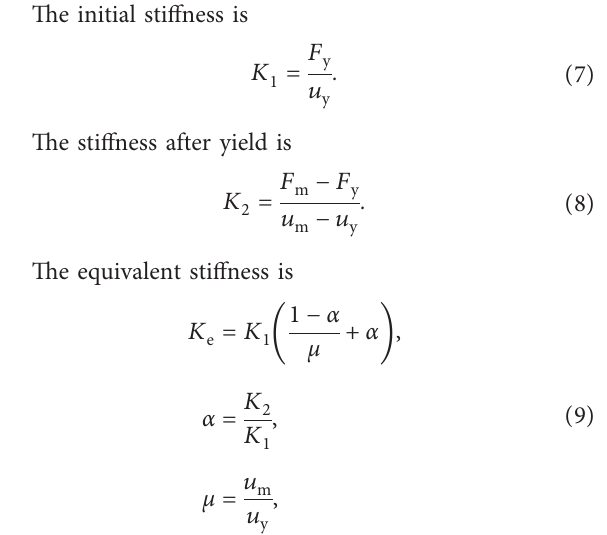
Figure 3: Force diagram of the shear deformation of the rubber layer in the DATD. F : shear force along length or width of the rectangular shear plate, F r : resultant shearing force of the quarter- ring steel